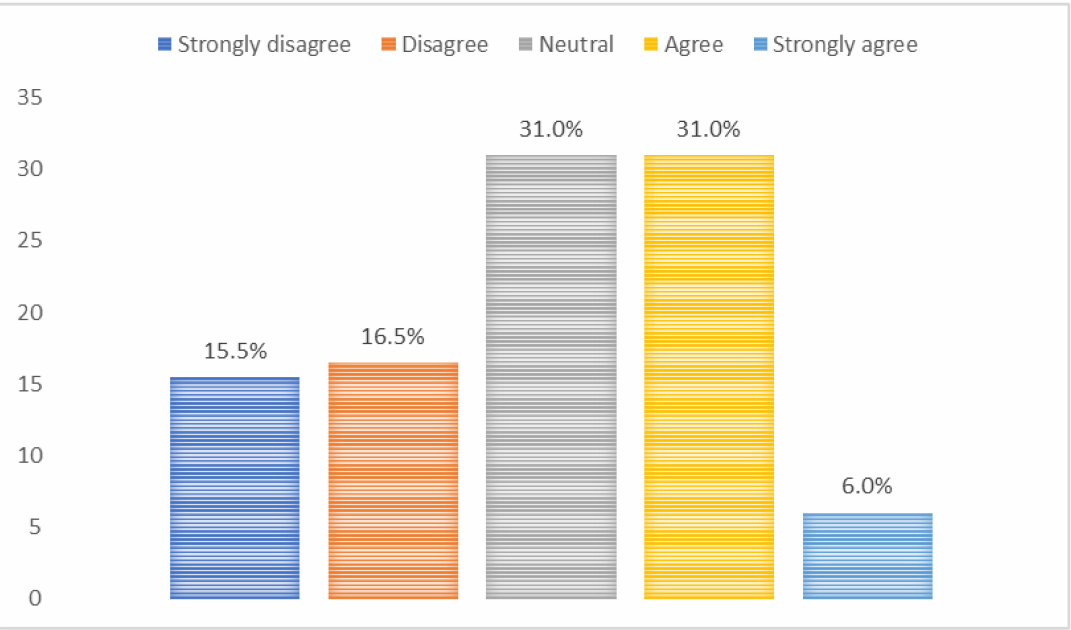
Figure 4. The ability of mHealth apps to help users set personal health goals that they were not able to